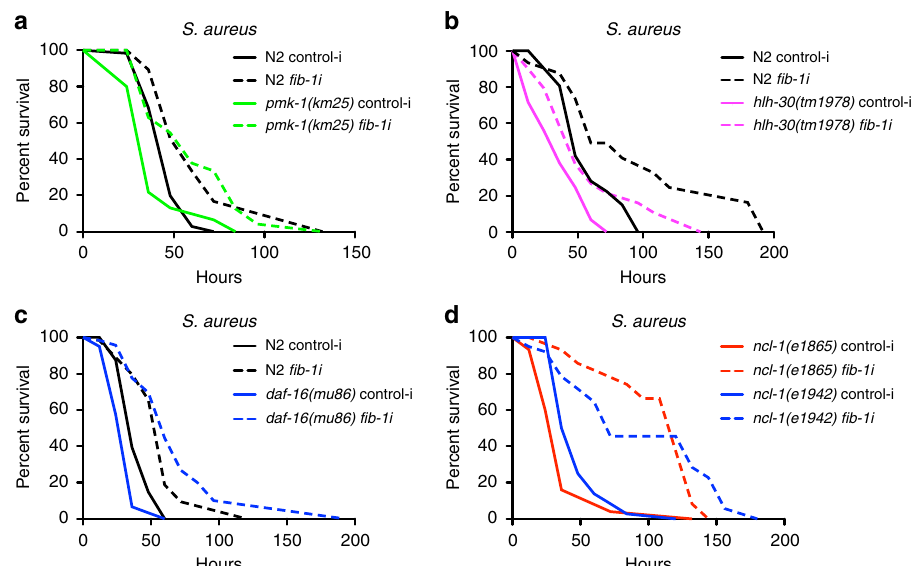
Fig. 3 fi b-1 / fi brillarin reduction improves resistance of infection-sensitive mutants. a – d fi b-1 RNAi signi fi cantly improves the survival of infection-sensitive pmk-1(km25) ( P = 0.0001), hlh-30(tm1978) ( P = 0.0021), daf-16(mu86) ( P < 0.0001) and ncl-1(e1865 and e1942) mutants ( P < 0.0001) upon S. aureus infection. Survival experiments were performed three times independently. P -values were calculated by log-rank